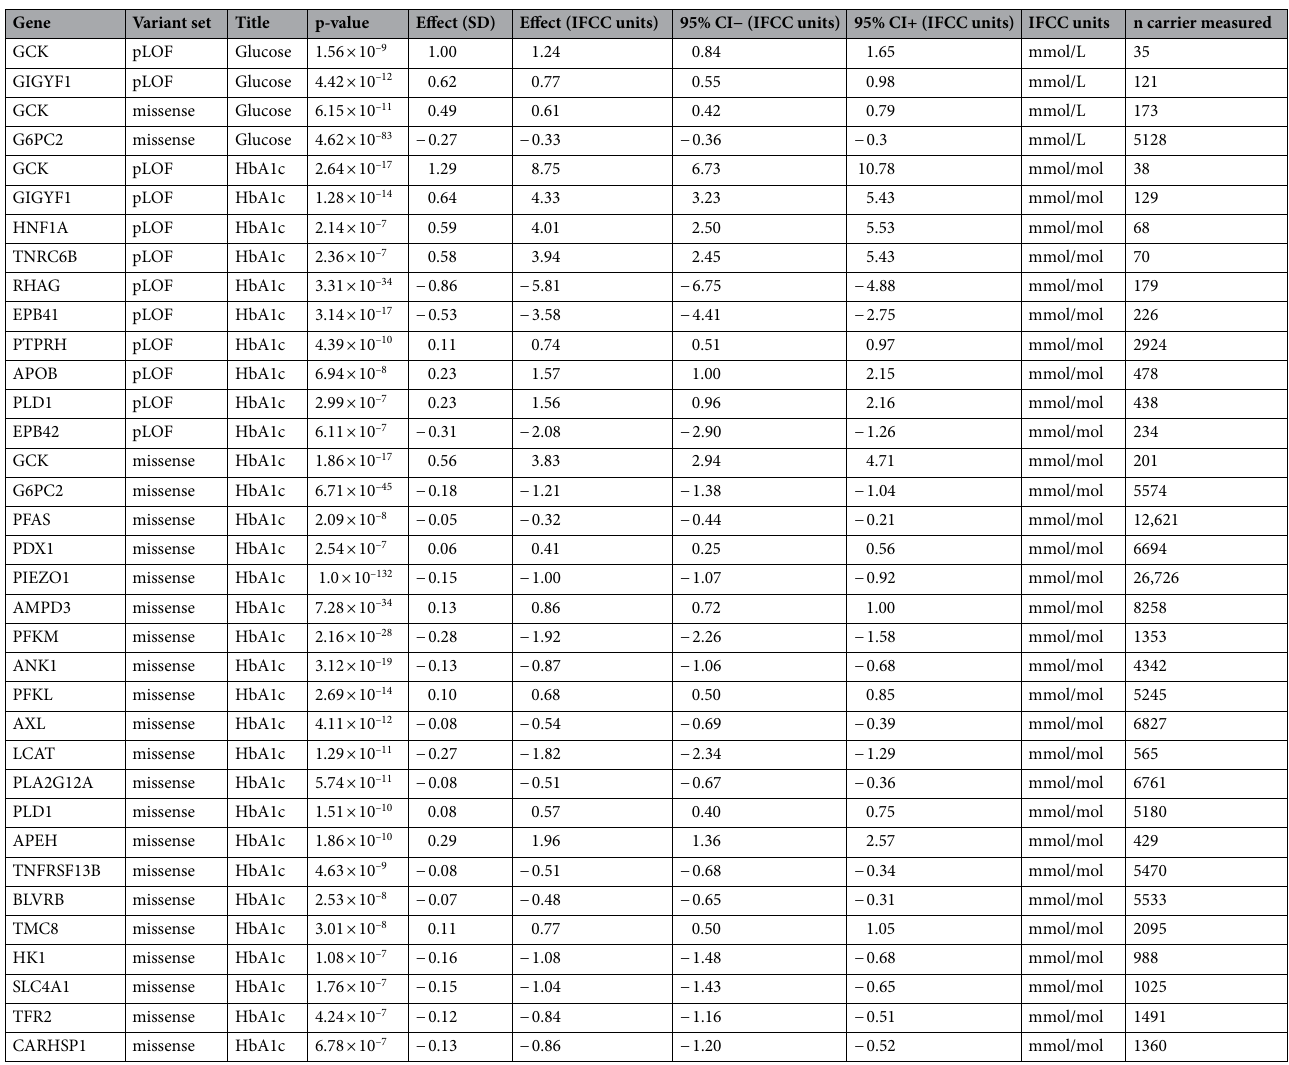
Table 1. Gene-level associations with glucose and HbA1c levels. pLOF or damaging missense variants (CADD score ≥ 25) were aggregated per gene. The effect is shown in standard deviations (SD) of transformed values as well as in International Federation of Clinical Chemistry (IFCC) units. CI confidence